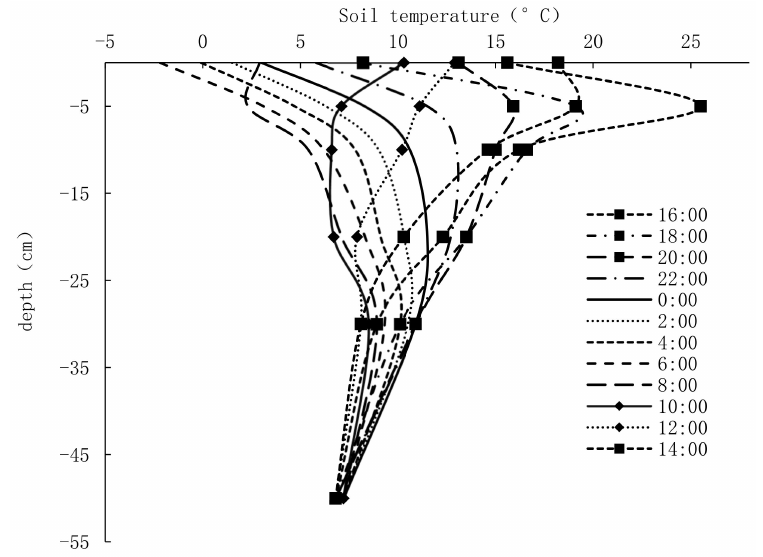
Figure 5. Soil temperature transport patterns near the surface.